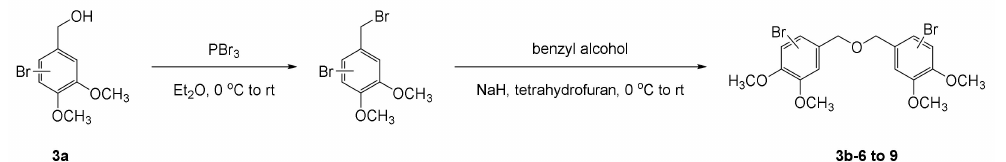
Scheme 4. General procedure of asymmetric methyl bromophenol